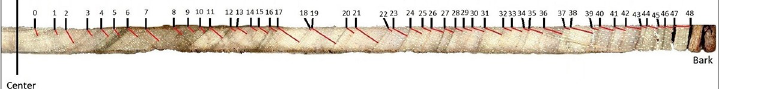
Fig 2. Increment core sample (labeled 81b), sampled from an Alchornea latifolia tree, with the enumeration of all ring boundaries. The length between the base boundary (0) and the last boundary (48) is 11.7 cm. Ring widths are marked with (red) diagonal lines that connect inner and outer boundaries, perpendicular to the ring’s inner